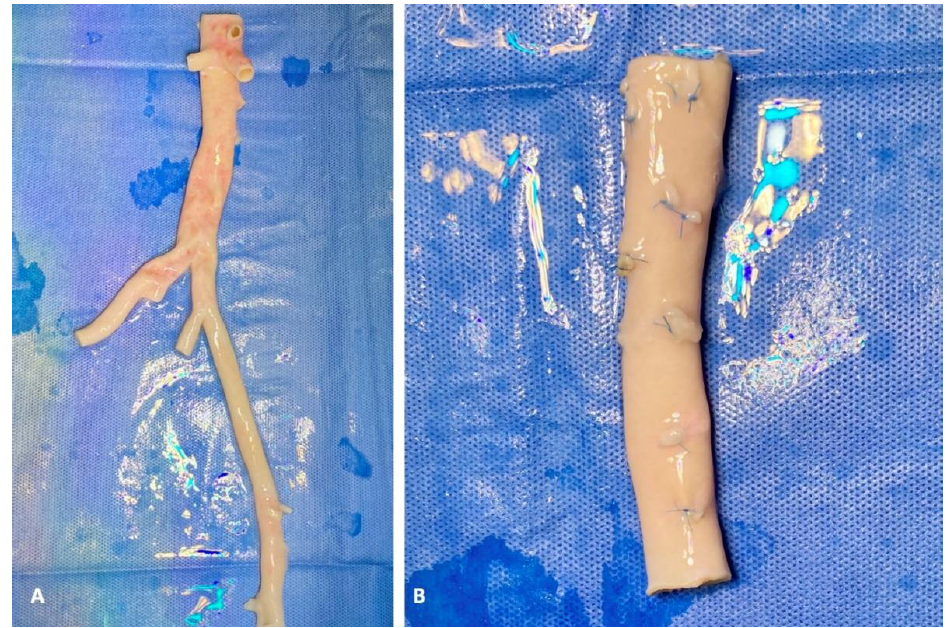
Figure 3. Cryopreserved aortic allograft before (Panel A ) and after (Panel B ) preparation.